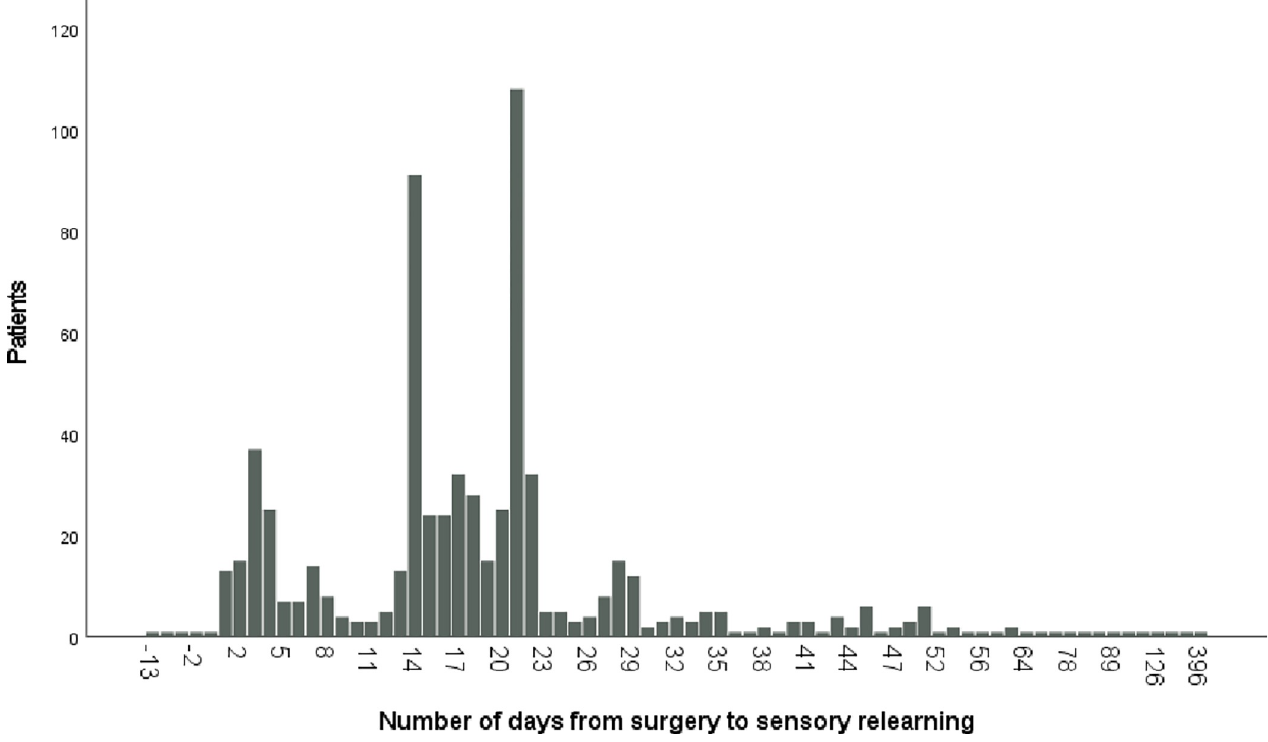
Fig 6. Bar chart presenting time from surgery to sensory